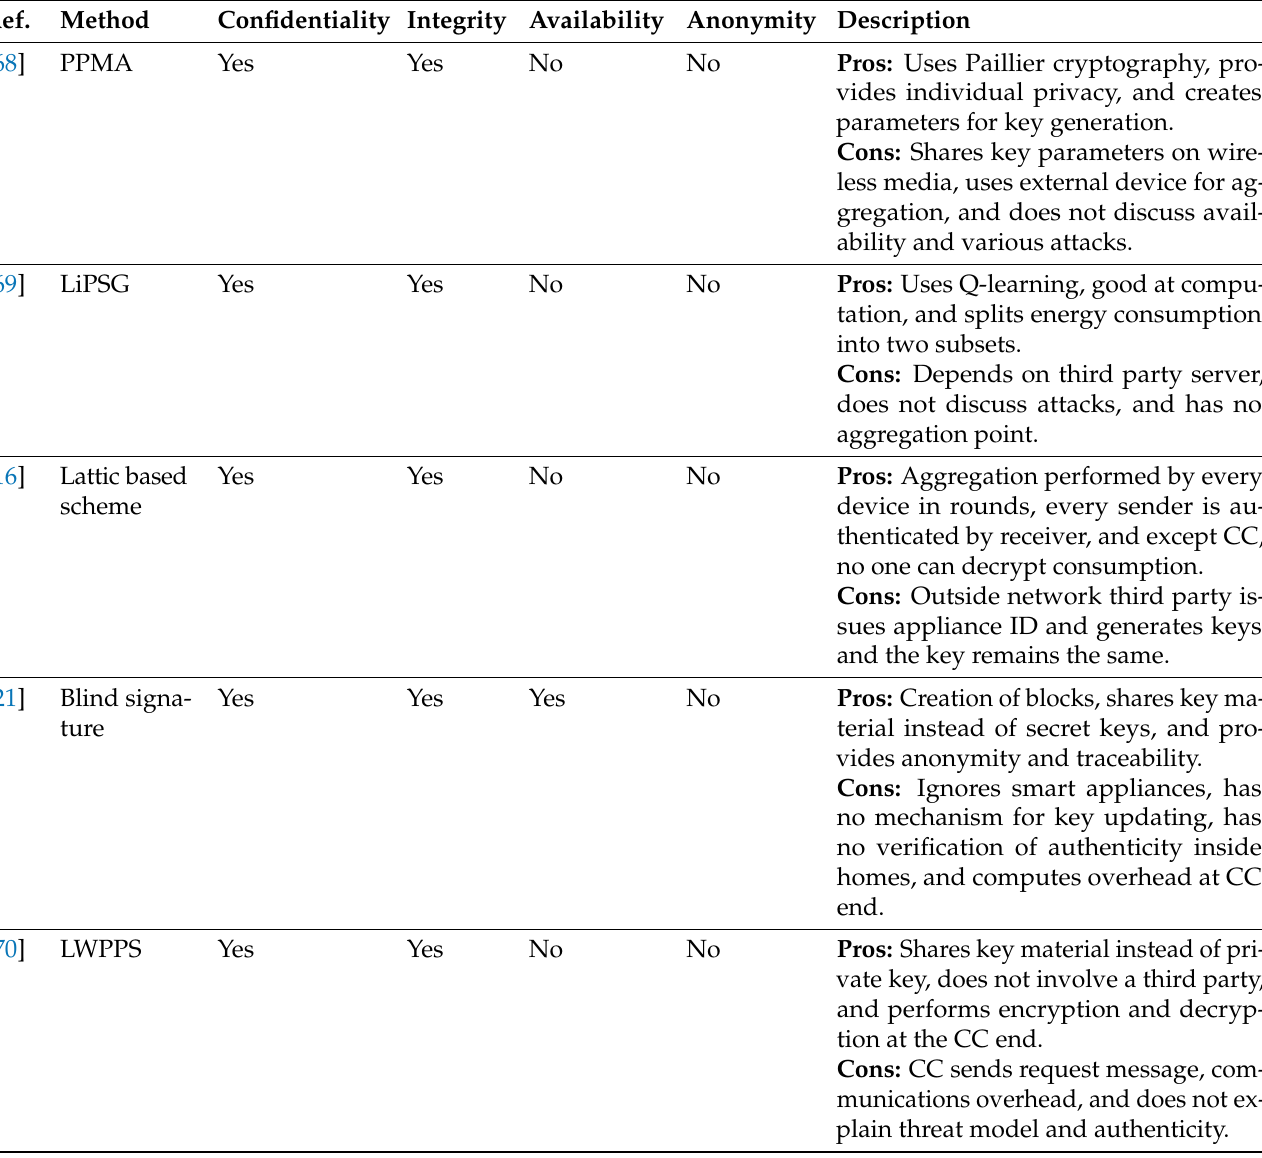
Table 2. Comparative analysis of CIA models and